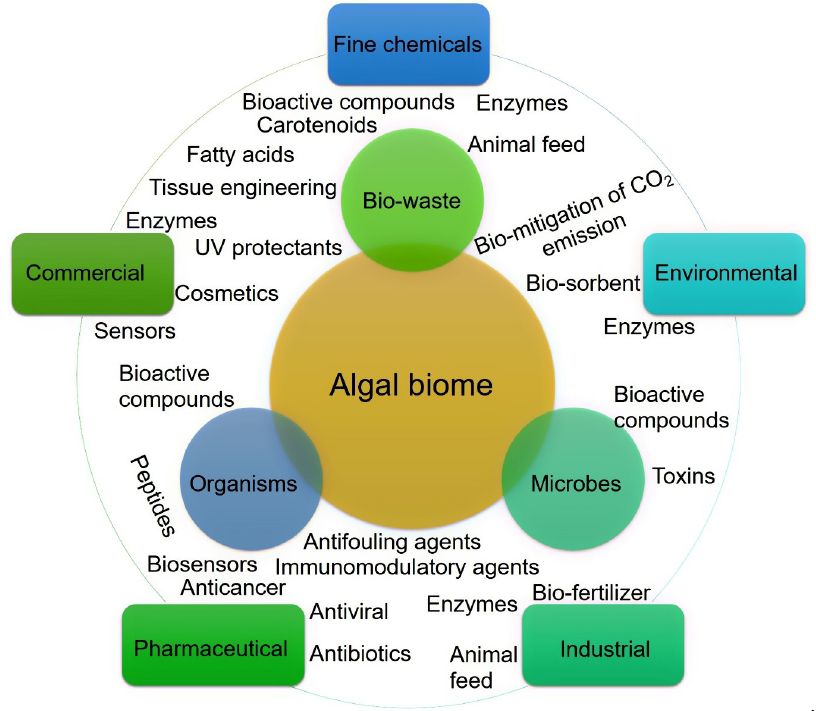
Figure 2. Algal biome as a prolific source of value-added products. The diversity of bioactive substances produced in the marine environment and their potential application routes.